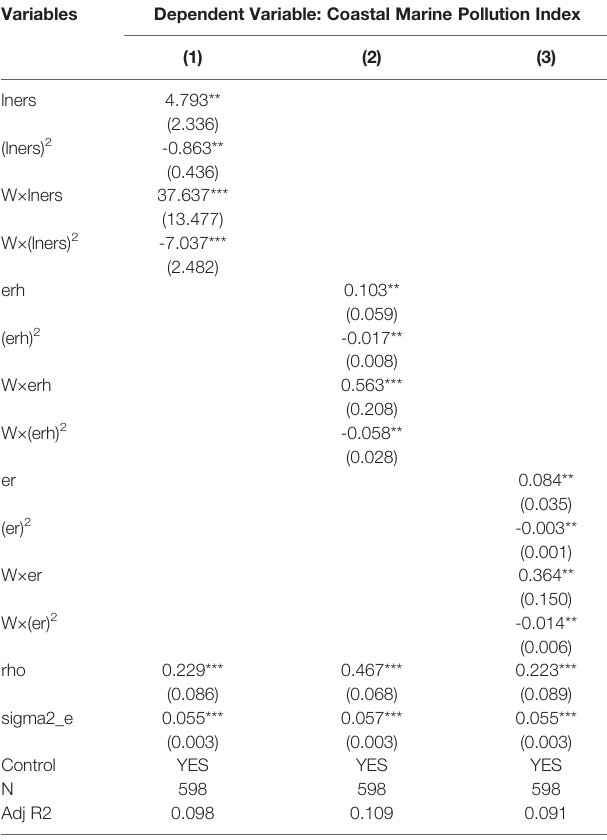
TABLE 9 | Spatial effect decomposition.